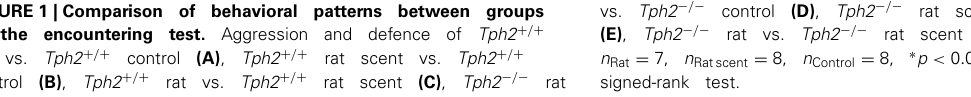
P = 0 . 023] expression were significantly different among the 3 groups. As compared with the control ones, Tph2 + / + hippocam- pal AR ( Figure 5A , LSD post-hoc t -tests, rat group: P = 0 . 003; rat-scent group: P = 0 . 001), ER α ( Figure 5A , LSD post-hoc t -tests, rat group: P = 0 . 000; rat-scent group: P = 0 . 000), TrkB-Tc ( Figure 5B , LSD post-hoc t -tests, rat group: P = 0 . 000; rat-scent group: P = 0 . 000), and 5-HTR1A ( Figure 5C , LSD post- hoc t -tests, rat group: P = 0 . 033; rat-scent group: P = 0 . 010) expression were